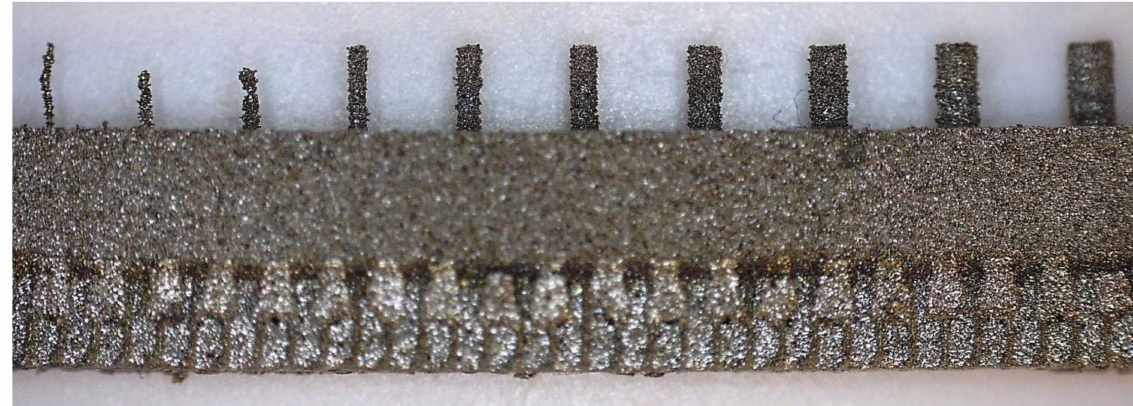
Figure 22. Front view of the model of cylinders with diameters of Ø1–Ø0.1 mm made of 17-4 PH steel.